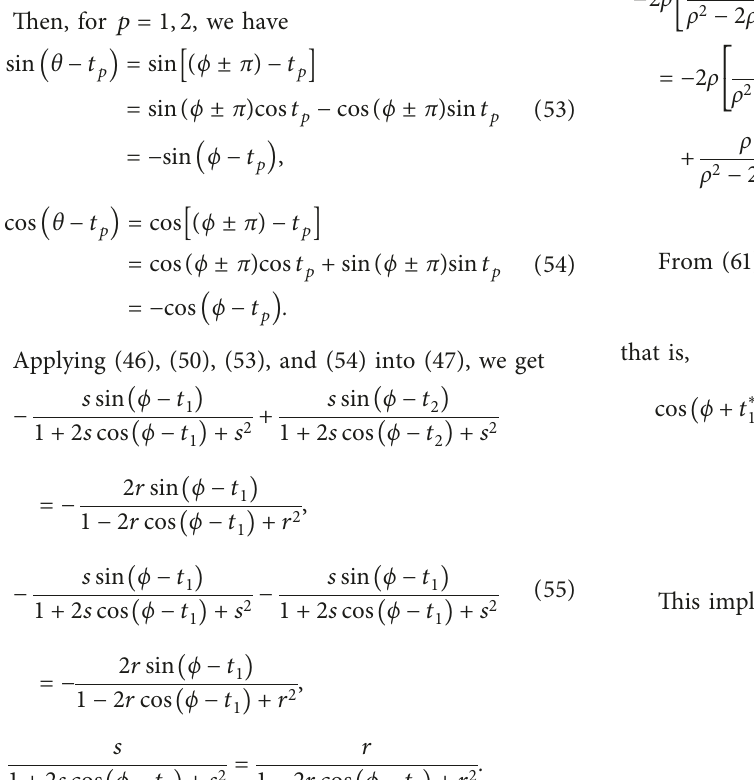
Figure 7: Graphs h Example